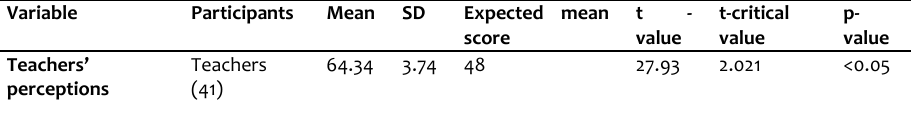
Table 2 : The teachers’ perceptions about peer-learning Variable